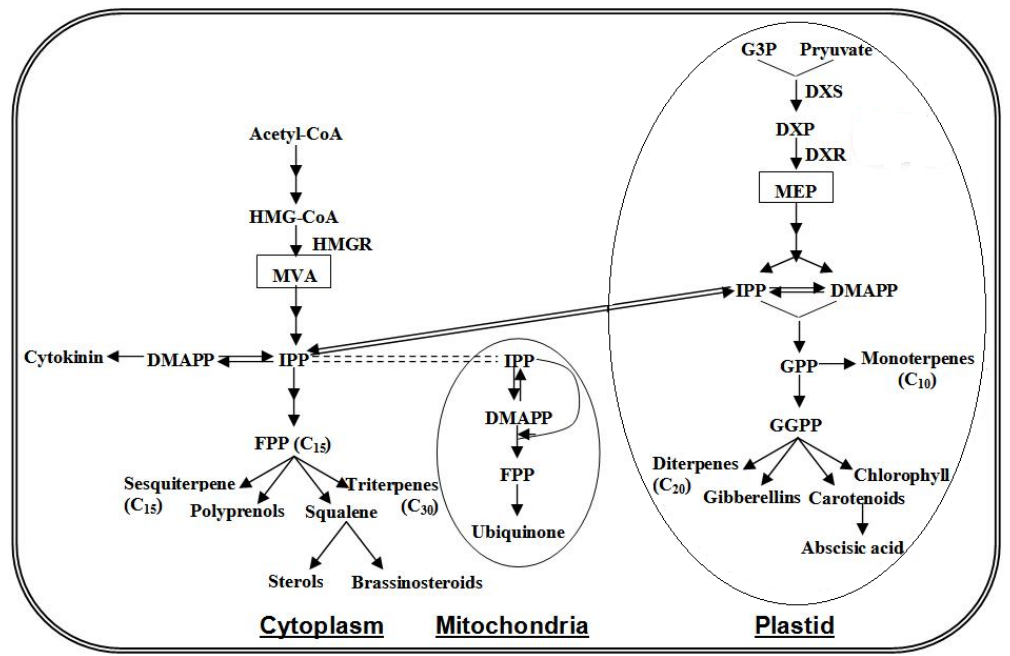
Scheme 3. The biosynthesis pathway of isoprenoids in plant cell. DMAPP, dimethylallyl diphosphate; DXP, 1-deoxy- D -xylulose-5-phosphate; DXS, DXP synthase; DXR, DXP reductoisomerase; FPP, farnesyl diphosphate; G3P, glyceraldehyde 3-phosphate; GPP, geranyl diphosphate; GGPP, geranyl geranyl diphosphate; HMGR, HMG-CoA